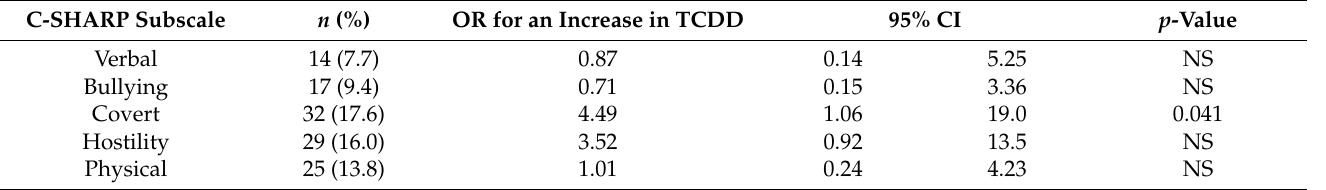
Table 2. Increased risks of high C-SARP subscale scores associated with an increase in TCDD exposure. C-SHARP